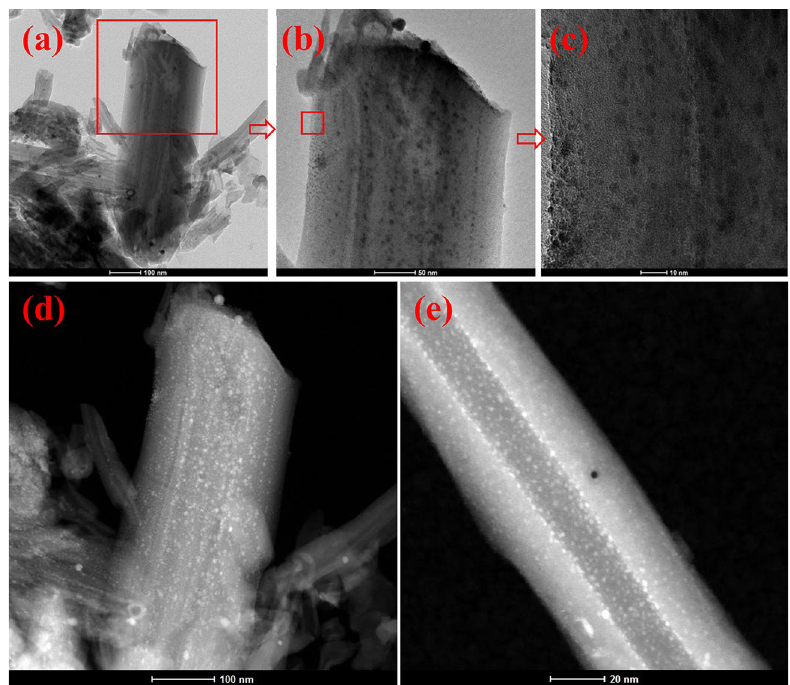
Figure 4. HR-TEM images of HNTs functionalized by iron oxide and silver